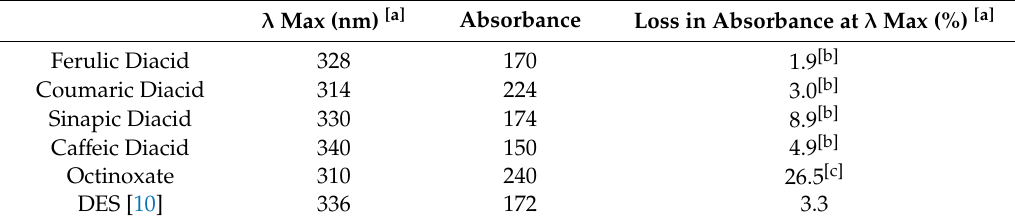
Table 6. UV analysis: λ max and